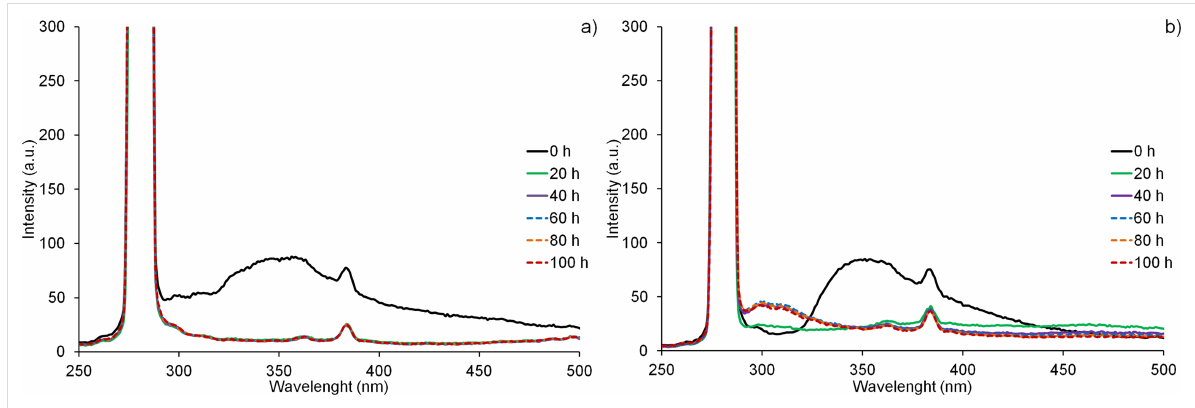
Figure 11: Fluorescence spectra of PBS nanocomposites with Mg 2 Al LDH fillers, during photodegradation tests at 60 °C; (a) PBS–LDH/HIS and (b) PBS–LDH/PHE. The excitation wavelength was 280 nm.